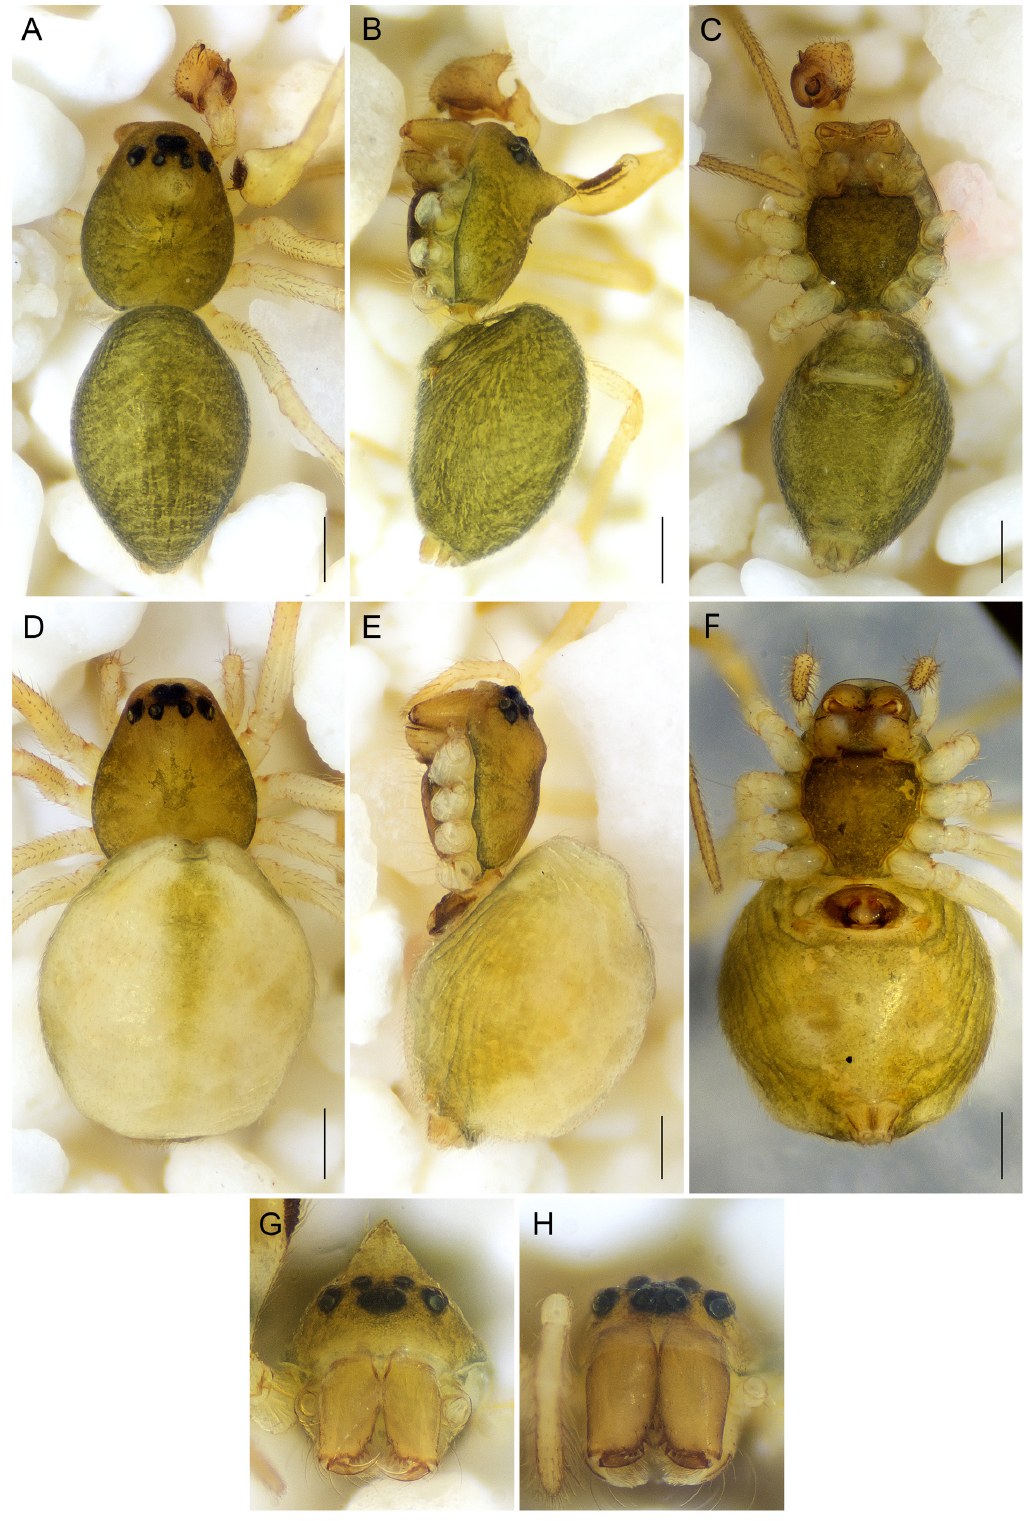
Fig. 1. Xim trenzado gen. et sp. nov. A–C, G . ♂ (ECOTAAR-004950). D–F, H . ♀ (ECOTAAR-005063). A–F . Habitus. A, D . Dorsal view. B, E . Lateral view. C, F . Ventral view. G, H . Carapace in frontal view. Scale bars: A–F = 0.25